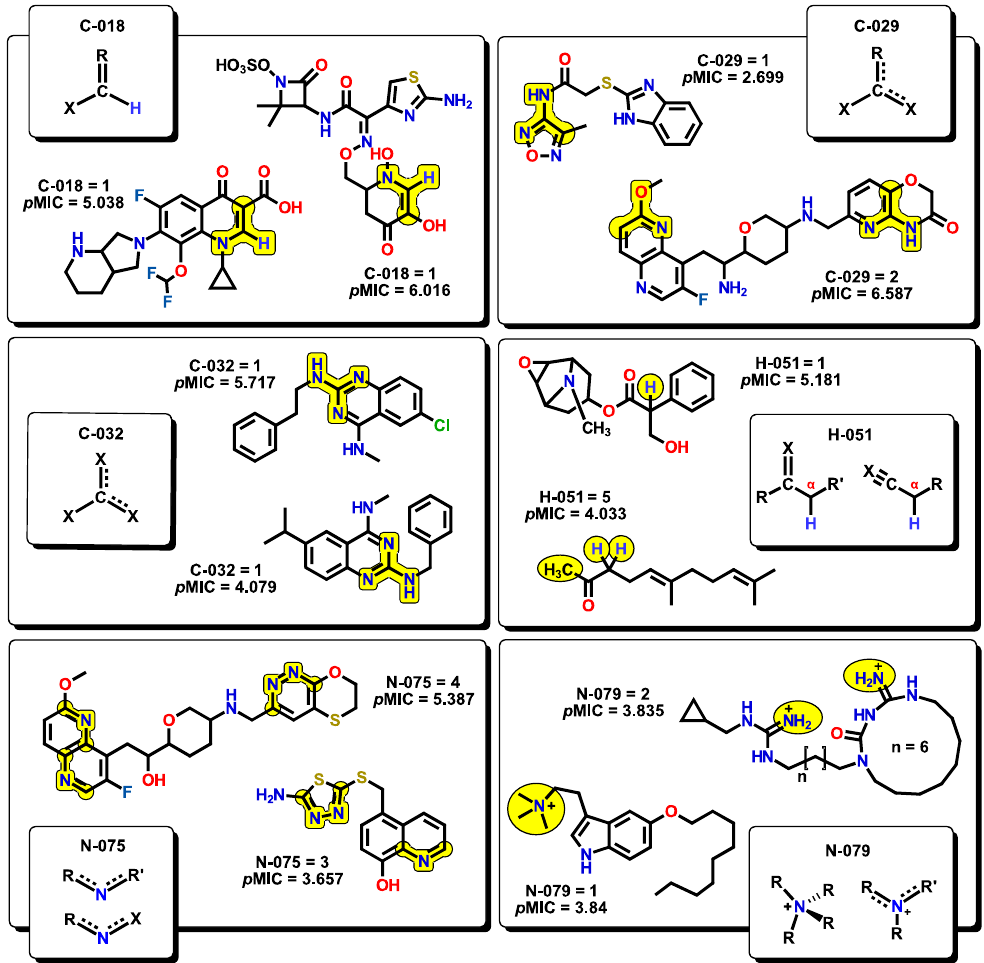
Figure 11. Atom-centered fragments (ACF) descriptors with representative molecules that incorporate them within their structures.